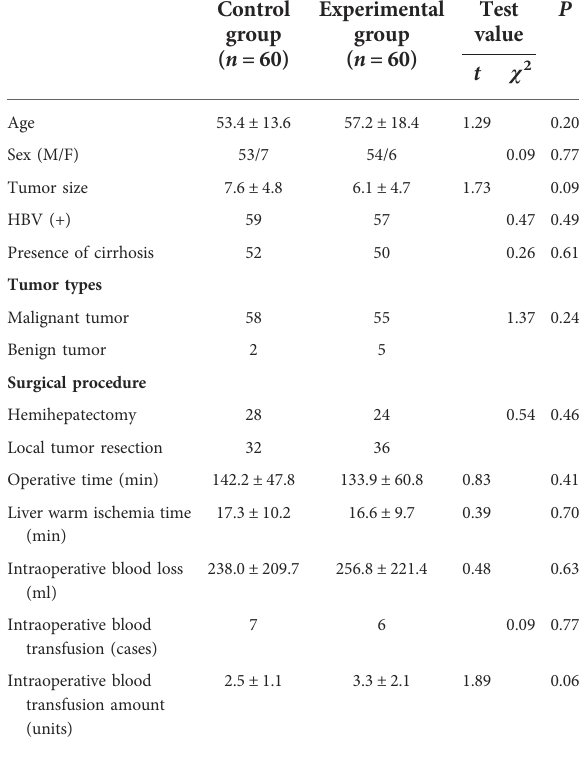
TABLE 1 Comparison of the general data between the two groups of